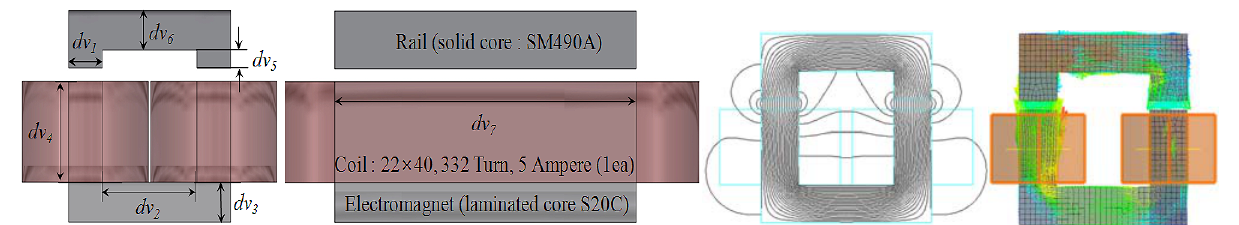
Figure 8. Design variables and flux pattern (2D and 3D